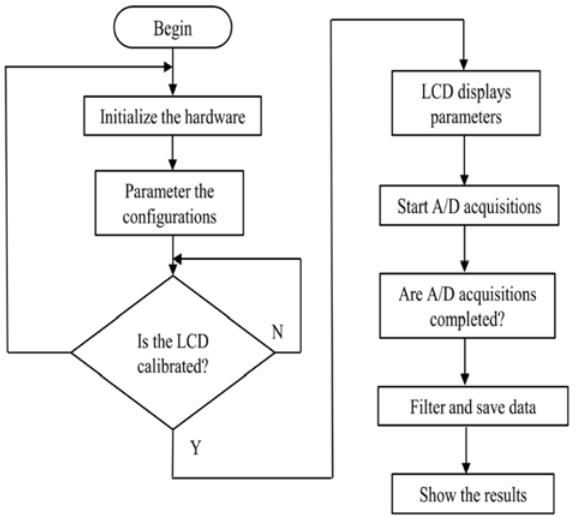
Fig. 6. Flowchart of the algorithm to eliminate the offset